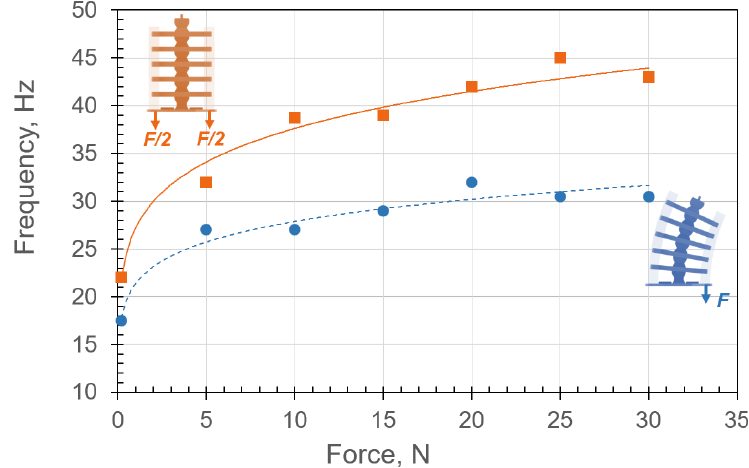
Figure 18. Undulation frequency for single- and double-sided tension configurations in blue and orange, respectively. The frequency appears to plateau asymptotically as the internal force is increased for both